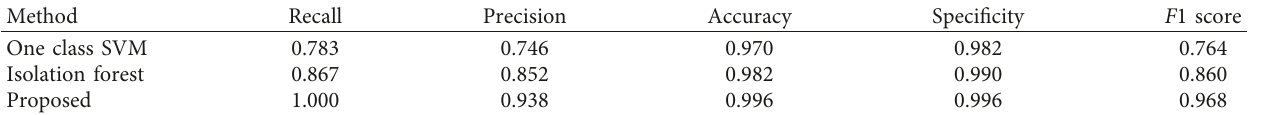
Table 2: Different method comparison for anomaly detection of seawater